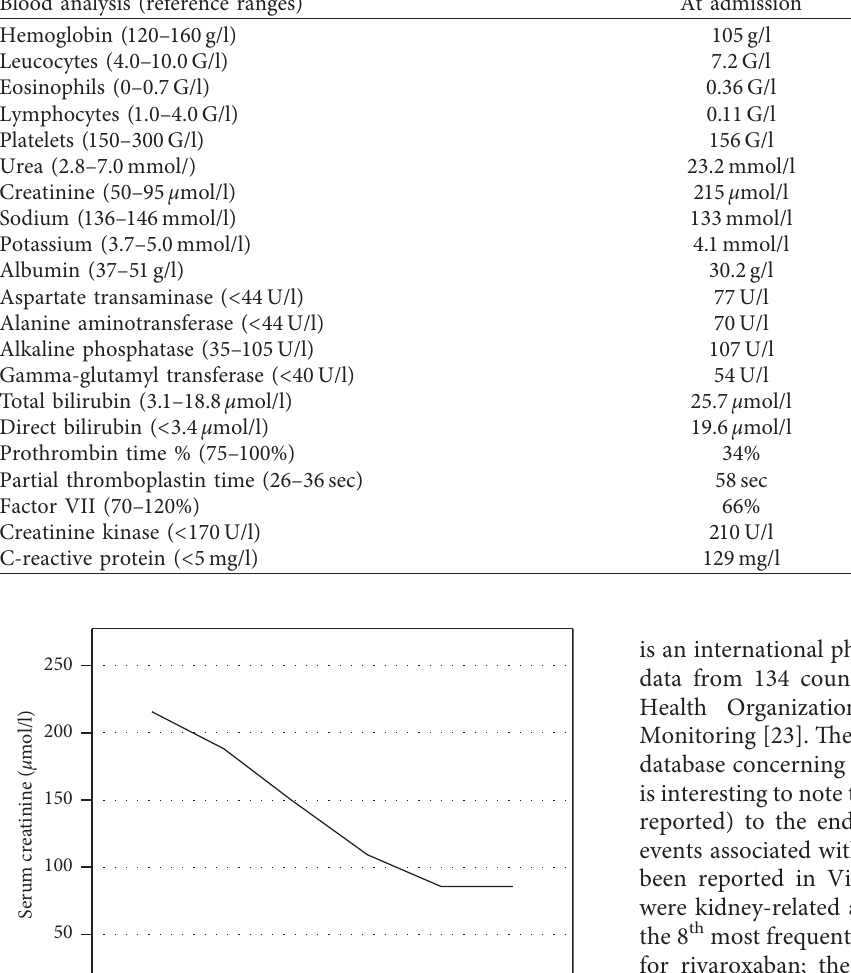
Table 1: Laboratory results of the patient at admission and at discharge from our hospital. Blood analysis (reference ranges)